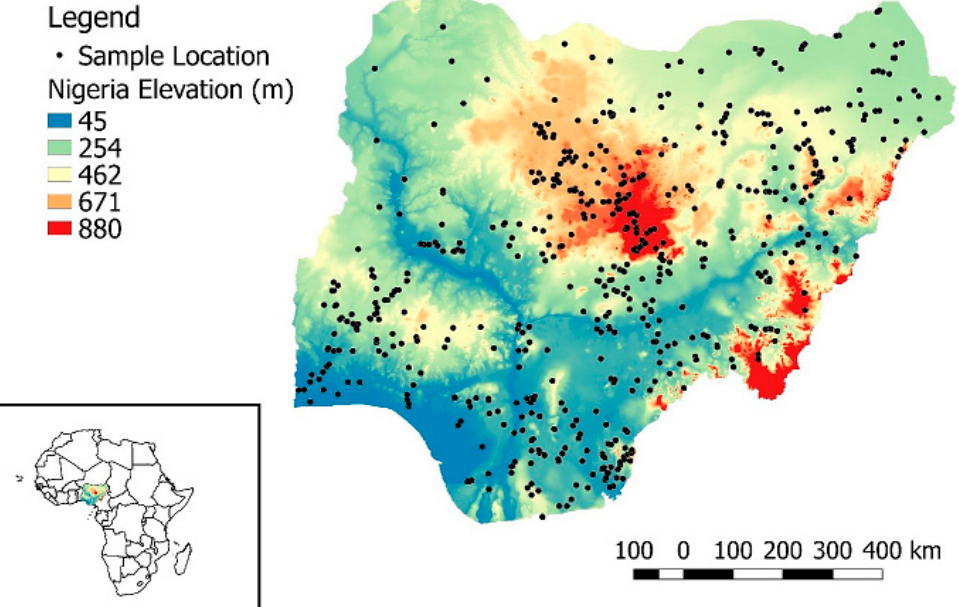
Figure 1. Map of Nigeria, showing the location of sample sites. ISPRS Int. J. Geo-Inf. 2020 , 9 , x FOR PEER REVIEW